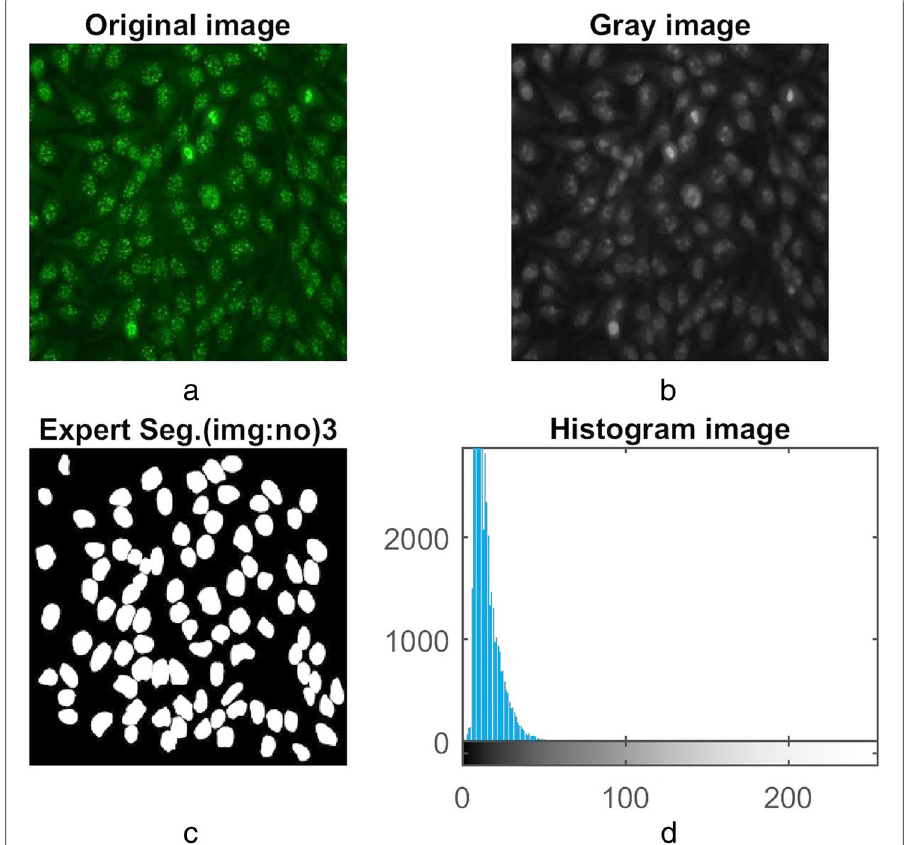
Fig. 1 a Original image. b Its gray level. c Expert segmentation. d Image